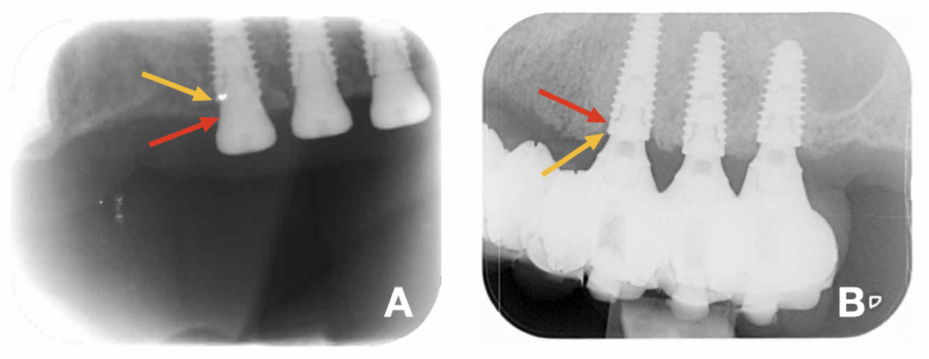
Figure 2. Radiograph obtained at the day of implant placement ( A ), and after 3–5 years of function ( B ). The yellow arrow indicates the reference point located at implant–abutment interface; the red arrow indicates the bone-to-implant contact